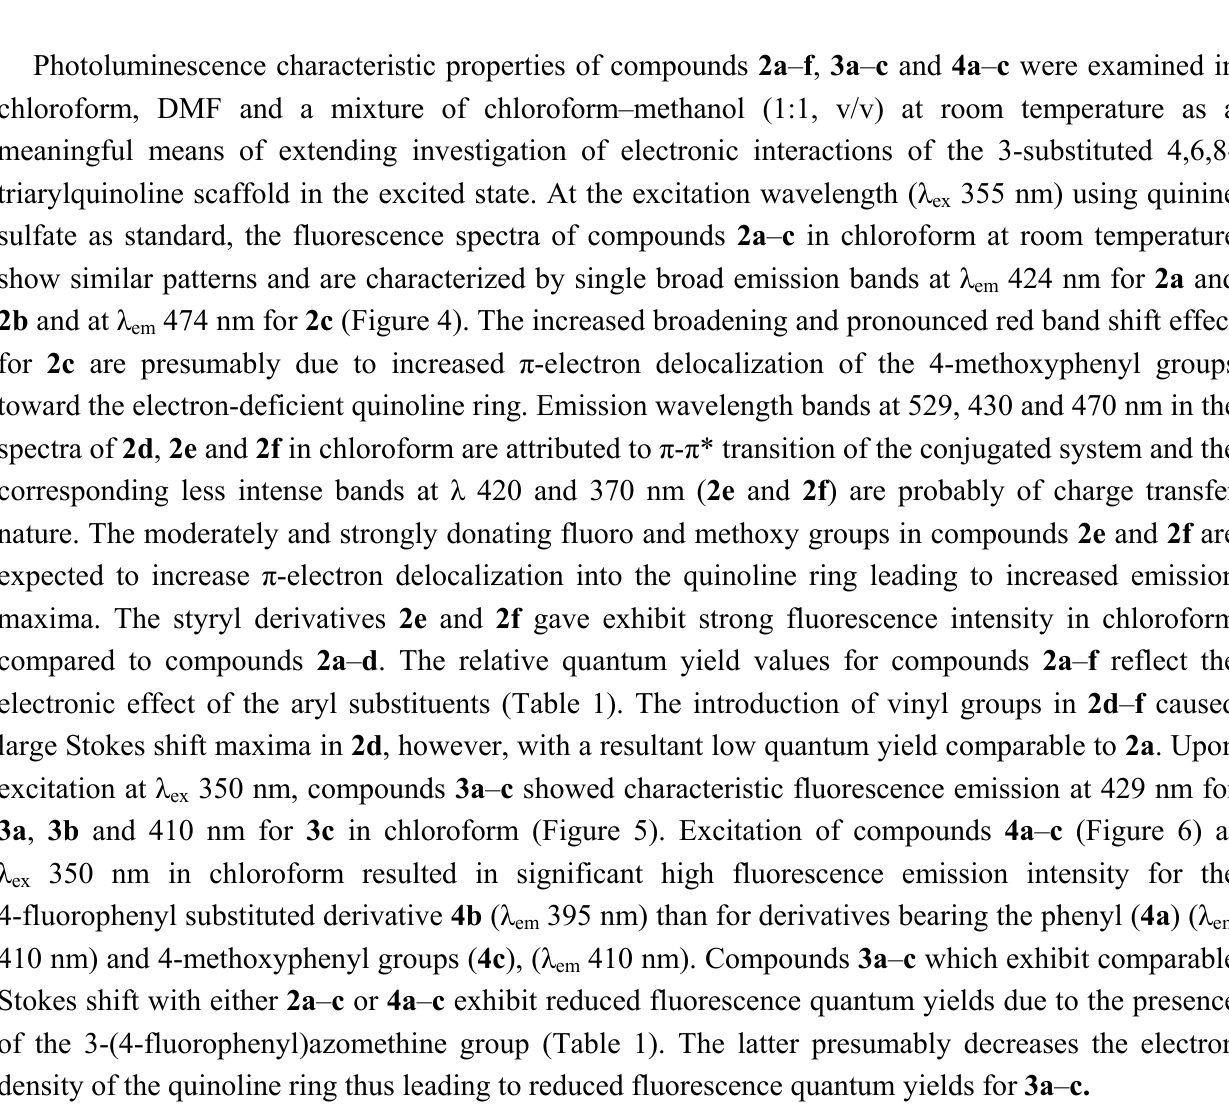
= 355nm) in CHCl ex